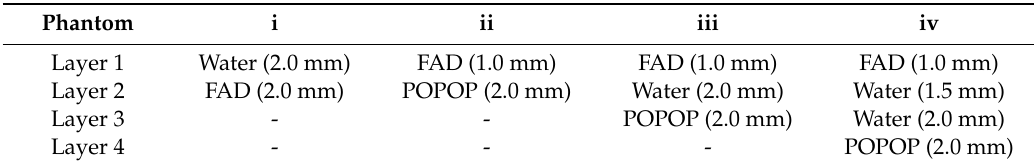
Table 2. Reference fluorophores and thickness of each layer of the phantoms studied: The tip of the fiber probe was placed in contact with the top surface of layer 1. The distance to the fiber probe increased from layers 1 to 4. A diagram of each phantom is shown in Figure